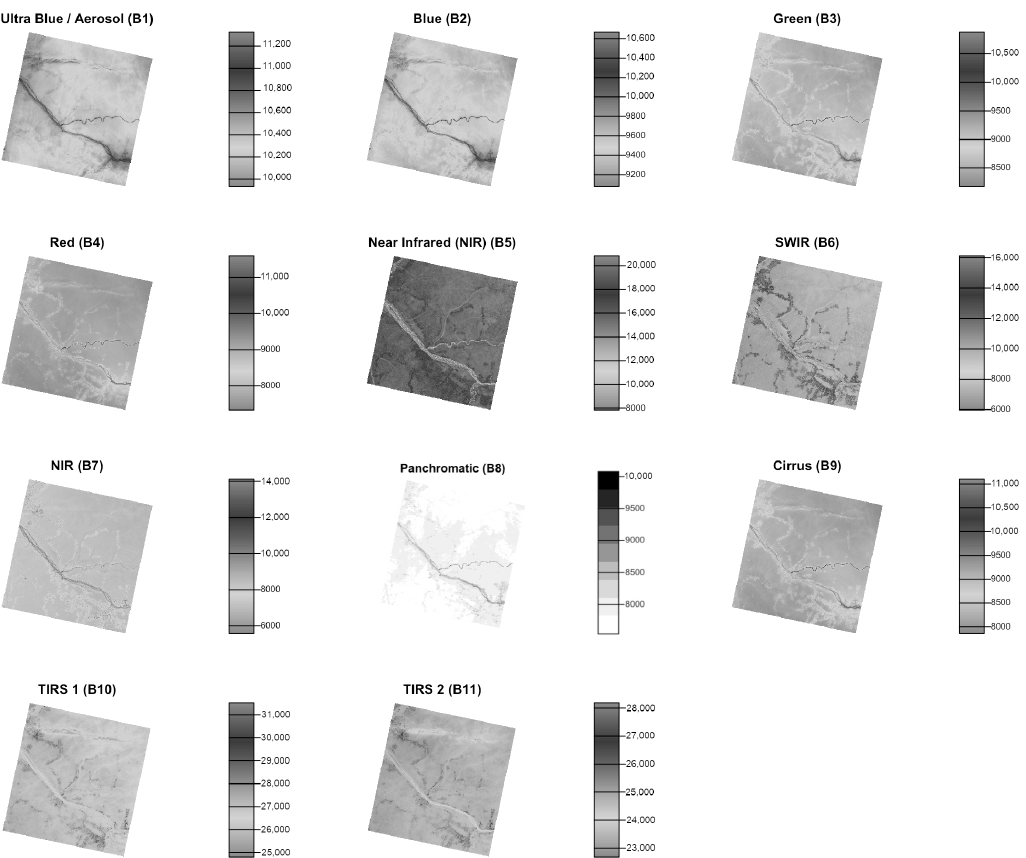
Figure 4. Composite of monochrome 11 bands: Landsat-8 OLI / TIRS C1 for Basoko region (Arowumi and Congo rivers). Multi-spectral image ’LC81770592022039LGN00’: ultra blue (B1), blue (B2), green (B3), red (B4), near infrared (NIR) (B5), shortwave infrared (SWIR) 1 (B6), shortwave infrared (SWIR) 2 (B7), panchromatic (B8), cirrus (B9), thermal infrared (TIRS) 1 (B10), TIRS2 (B11). Plotting: R. The multi-facetted plot of the individual bands of the Landsat OLI / TIRS image has been plotted using libraries ‘raster’ and ‘terra’ (version 1.2.11), by the code in Listing 3. Here the case is given for the image covering Basoko (2022), applied for other